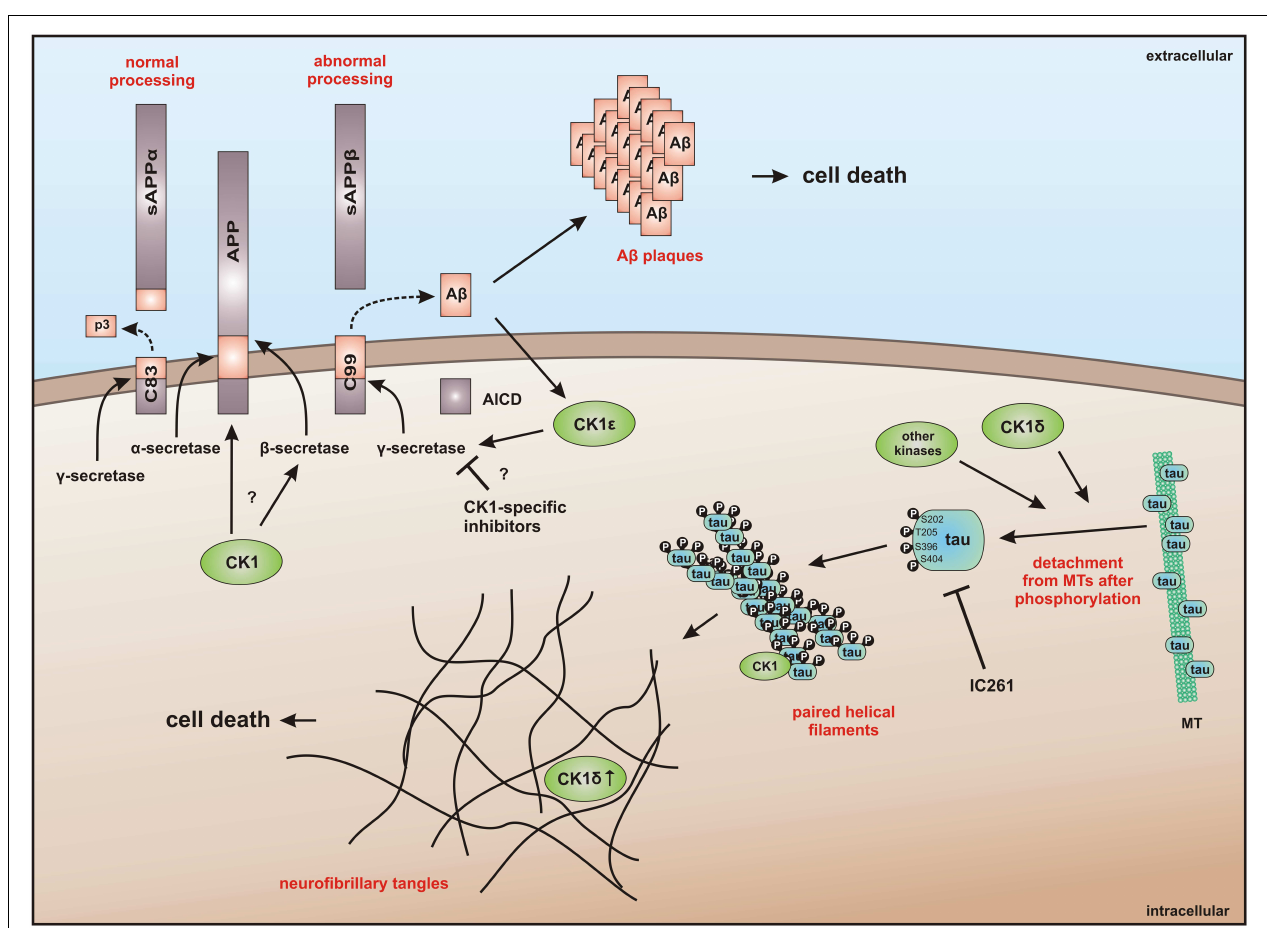
progressive supranuclear palsy, Parkinsonism–dementia complex and pallido-ponto-nigral degeneration (383, 385).The overexpression of constitutively active CK1 ε , proposed to be involved in processing of amyloid precursor protein (APP) on γ -secretase level, results in an increase of amyloid-beta (A β ) production, which is attenuated by use of CK1-specific inhibitors (386). In addition, Höttecke et al. (381) could show that the inhibition of γ -secretase by one of these inhibitors does not depend on CK1 δ . An in silico analysis further revealed multiple CK1 consensus phosphorylation sites in the intracellular regions of APP, β -secretase, and γ -secretase subunits. Conversely, A β seems to influence CK1 activity